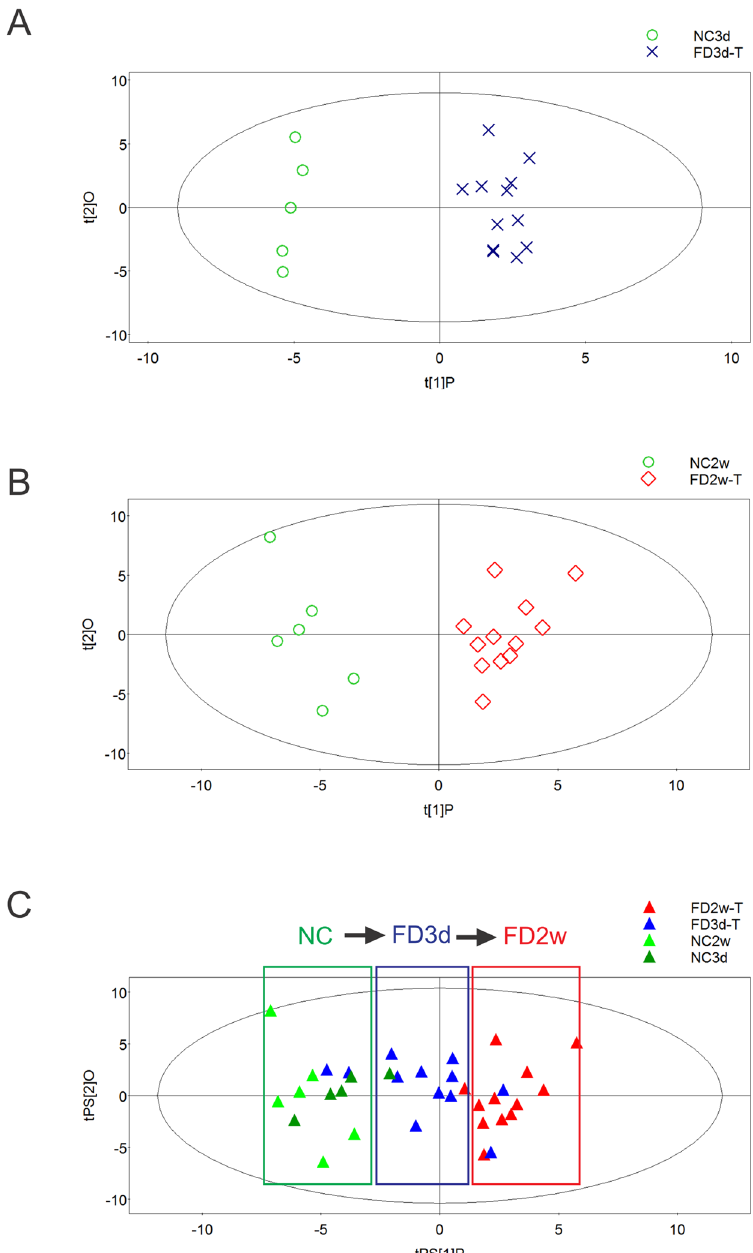
Figure 3. FD induced retinal metabolic profile shifts. Based on the content of 101 identified retinal metabolites, metabolome changes induced by 3 days and 2 weeks of FD were different from age-matched NC3d ( A ) and NC2w ( B ) using OPLS models. Samples from FD3d-T localized between FD2w-T and NC2w in the t predicted plot using NC3d and FD3d-T as a prediction set of the OPLS model discriminating FD2w-T and NC2w ( C ), which indicates an association between FDM development and metabolic profile changes. t[1]P: score calculated with predictive components; t[2]O: score calculated with orthogonal components. tPS[1]P: score calculated with predictive components of samples in prediction set (PS); tPS[2]O: score calculated with orthogonal components of samples in